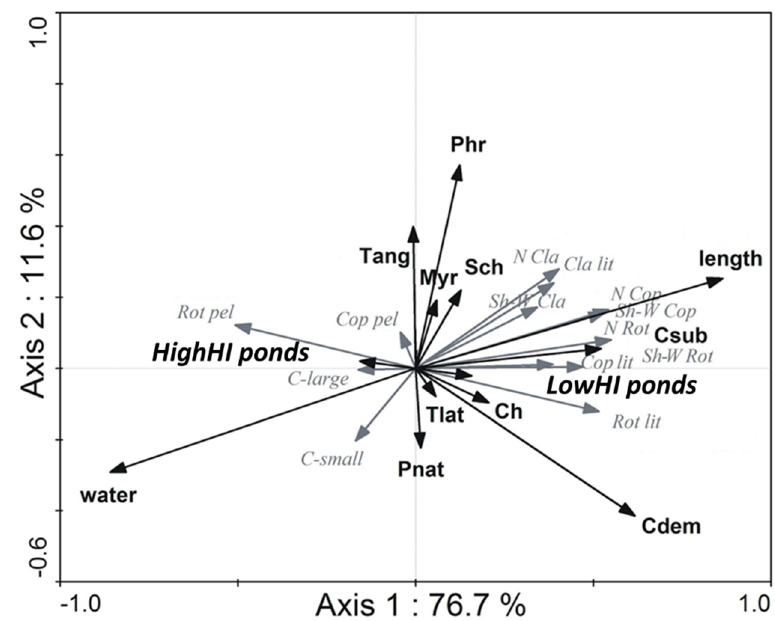
Figure 2. RDA diagram illustrating zooplankton community indices with habitats (water—the open water zone, Phr—Phragmites australis, Sch— Schoenoplectus lacustris , Tang— Typha angustifolia , Tlat— Typha latifolia , Cdem— Ceratophyllum demersum , Csub— Ceratophyllum submersum , Ch— Chara hispida and Chara tomentosa , Myr— Myriophyllum spicatum and Myriophyllum verticilatum , Pnat— Potamogeton natans ) and presence of fish in two types of water bodies: HighHI ponds—anthropogenically modified ponds and LowHI ponds—ponds of low level of human impact (legend: see Table 1).